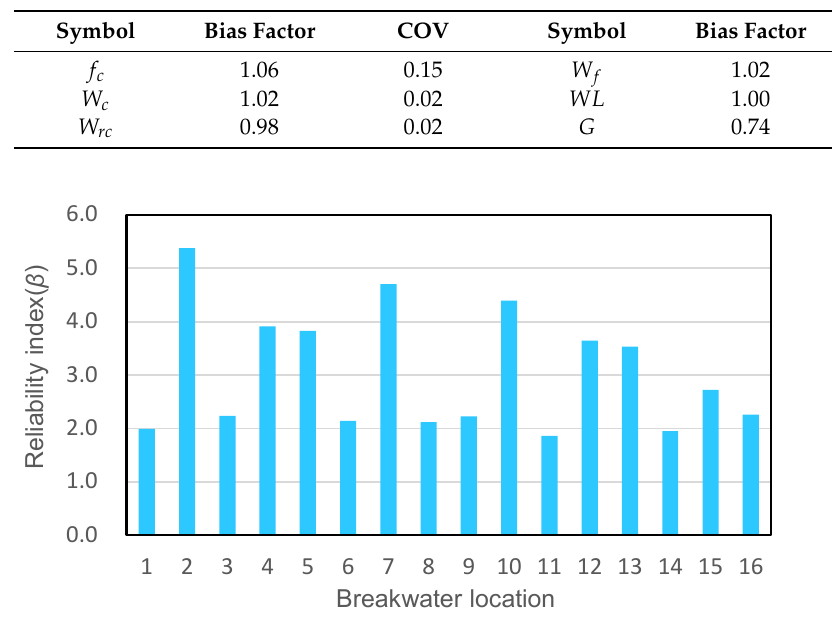
Figure 4. Reliability indices of breakwater (sliding).